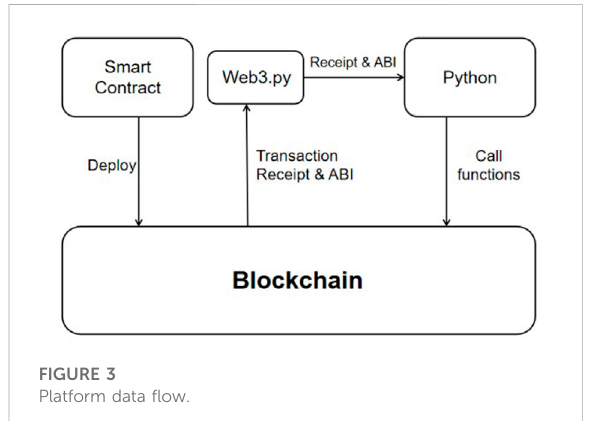
FIGURE 3 Platform data fl